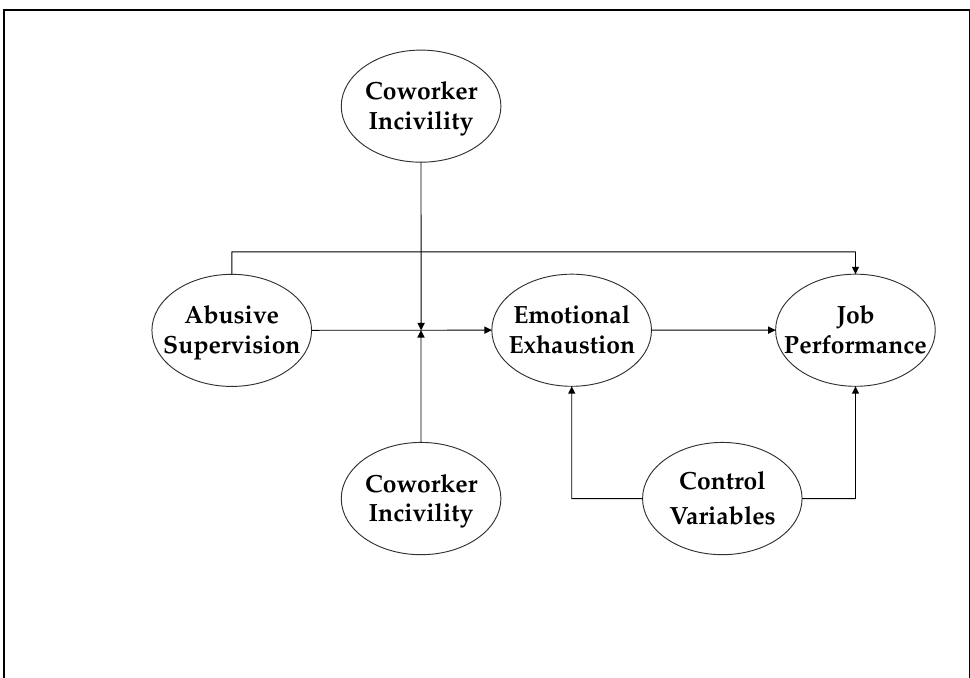
Figure 1. Proposed research model. For parsimony, the control variables are not included in this figure.